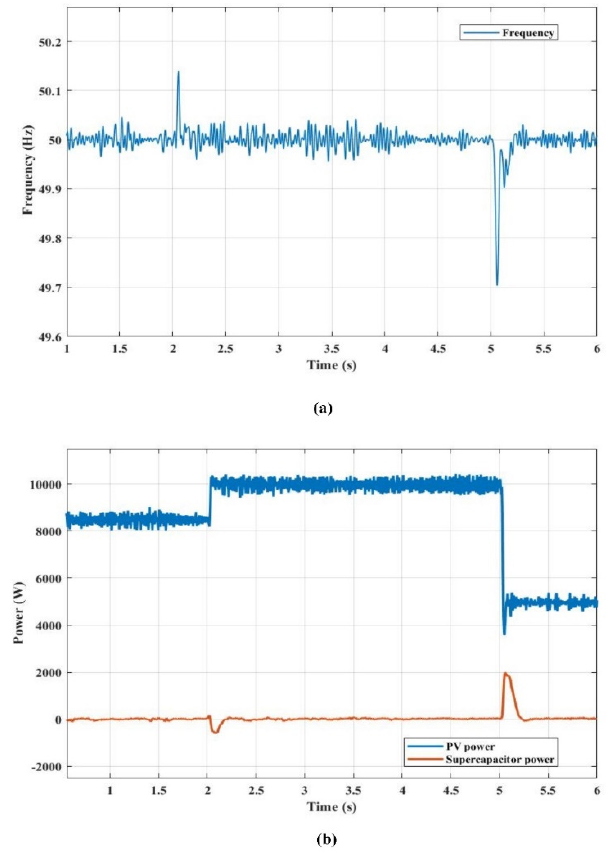
Figure 17. PV Power Variations ( a ) Frequency, ( b ) PV and supercapacitor power.